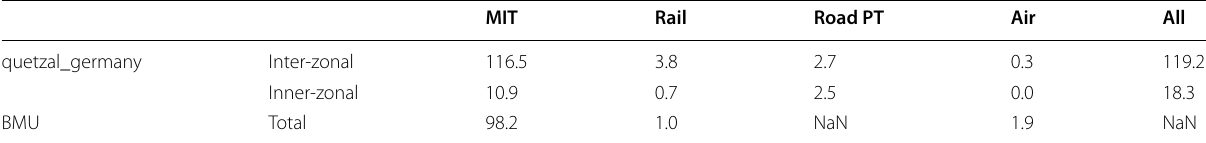
Column NM comprises non-motorised trips Table 5 Driving emissions (million tCO ) by mode from quetzal_germany results (the upper value shows modelled results, the lower 2eq value shows data from VP2030 and MiD2017) and values retrieved from [15] MIT Rail Road